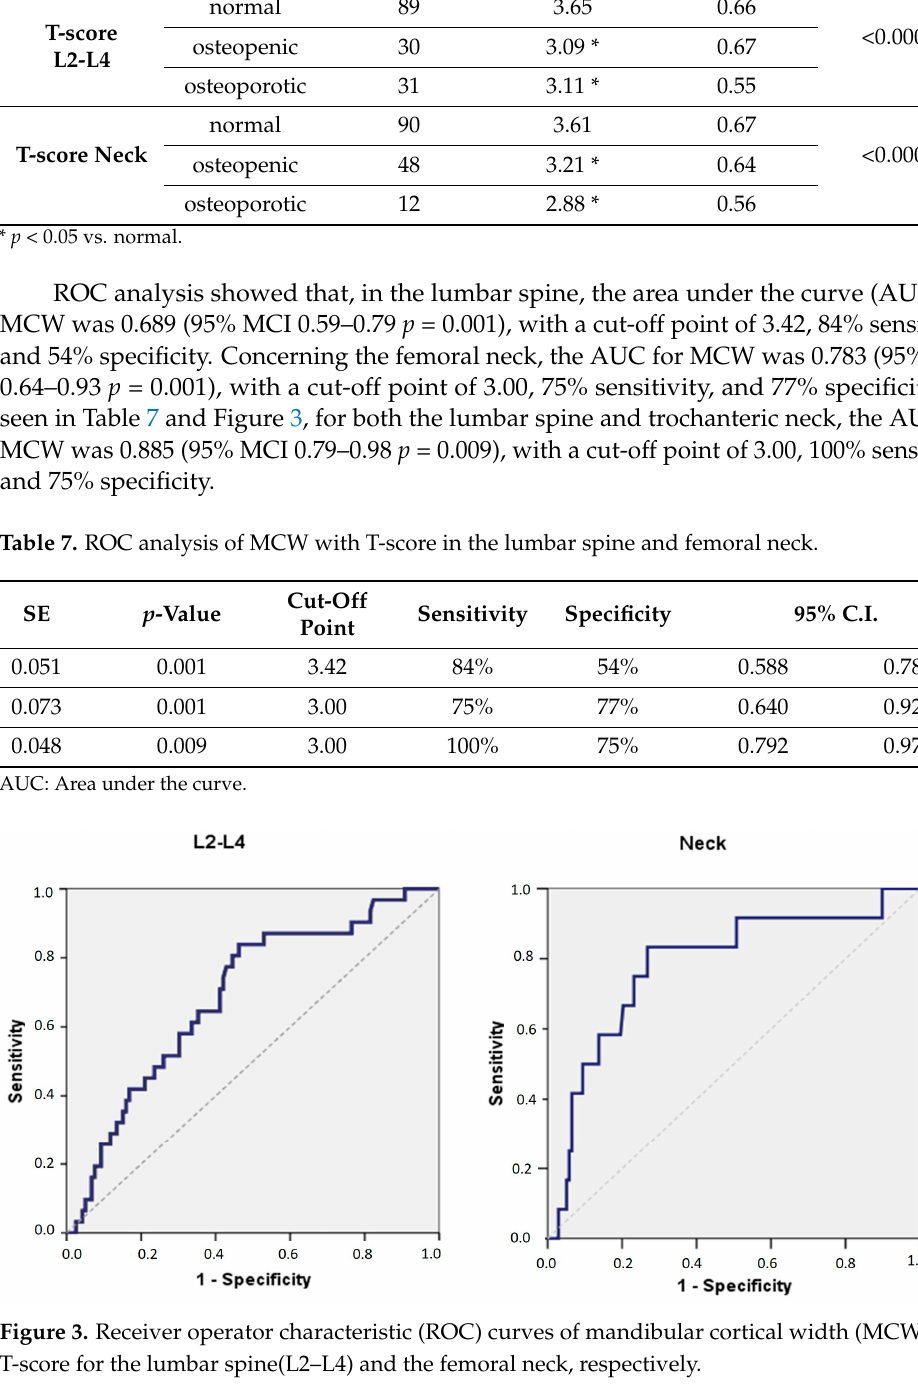
Table 6. Comparison of MCW score among T-score categories at different areas.